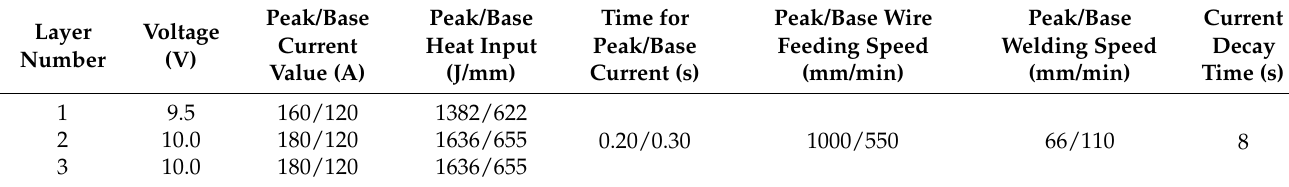
Table 2. The welding process